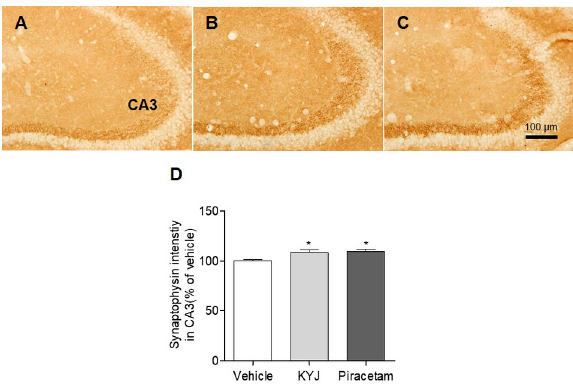
Figure 5. KYJ reinforced synapse formation in the mouse hippocampus. ( A – C ) Representative images of each group are shown: ( A ) vehicle-treated group, ( B ) KYJ 200 mg / kg / day p.o. group, ( C ) piracetam 200 mg / kg / day i.p. group. ( D ) The optical density of synaptophysin immunoreactivity in CA3 region was measured. * p < 0.05 vs. the vehicle-treated group.